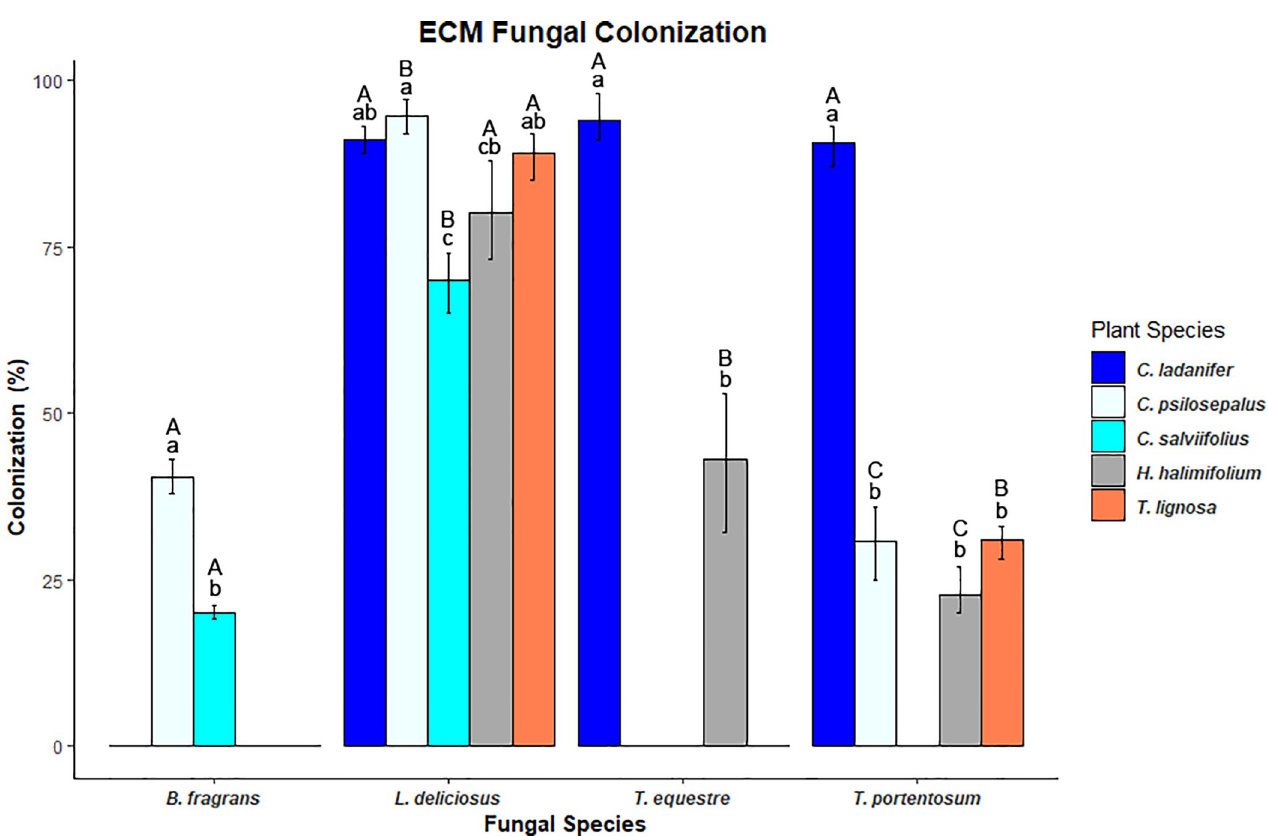
Fig 4. Root colonization percentages of different species of Cistaceae by T . equestre , T . portentosum , L . deliciosus , and B . fragrans . Lower case letters state for statistical differences in the colonization of the same fungi in different plants. Upper case letters state for statistical differences in the colonization of different fungi in the same plant (P < 0,05). (n =